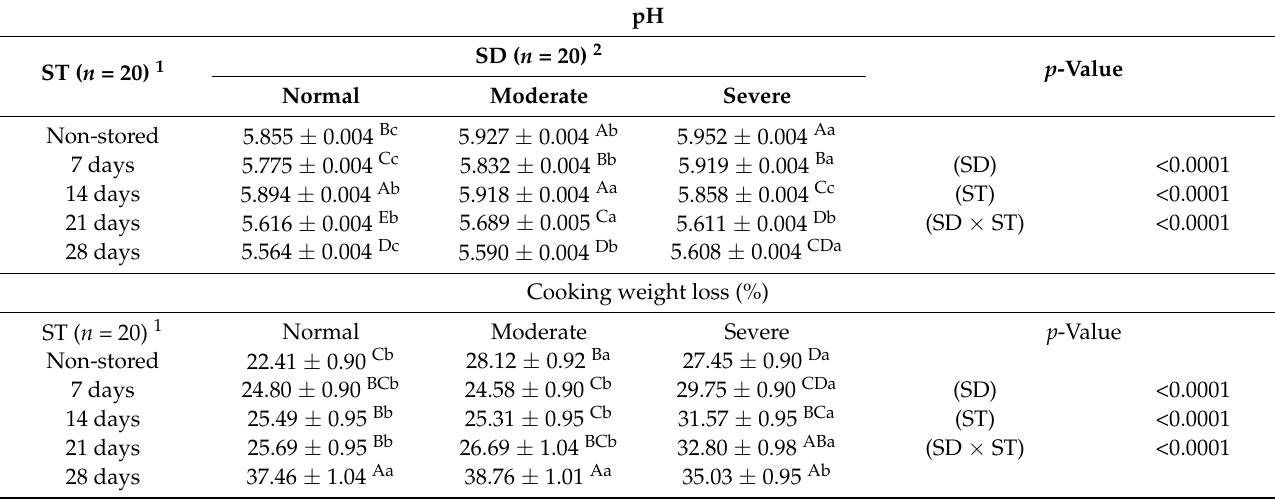
Table 5. Mean values of pH and cooking loss in fresh sausages produced with breast meat from Ross (AP95) broiler chickens without myopathies and affected by wooden breast myopathy after different storage